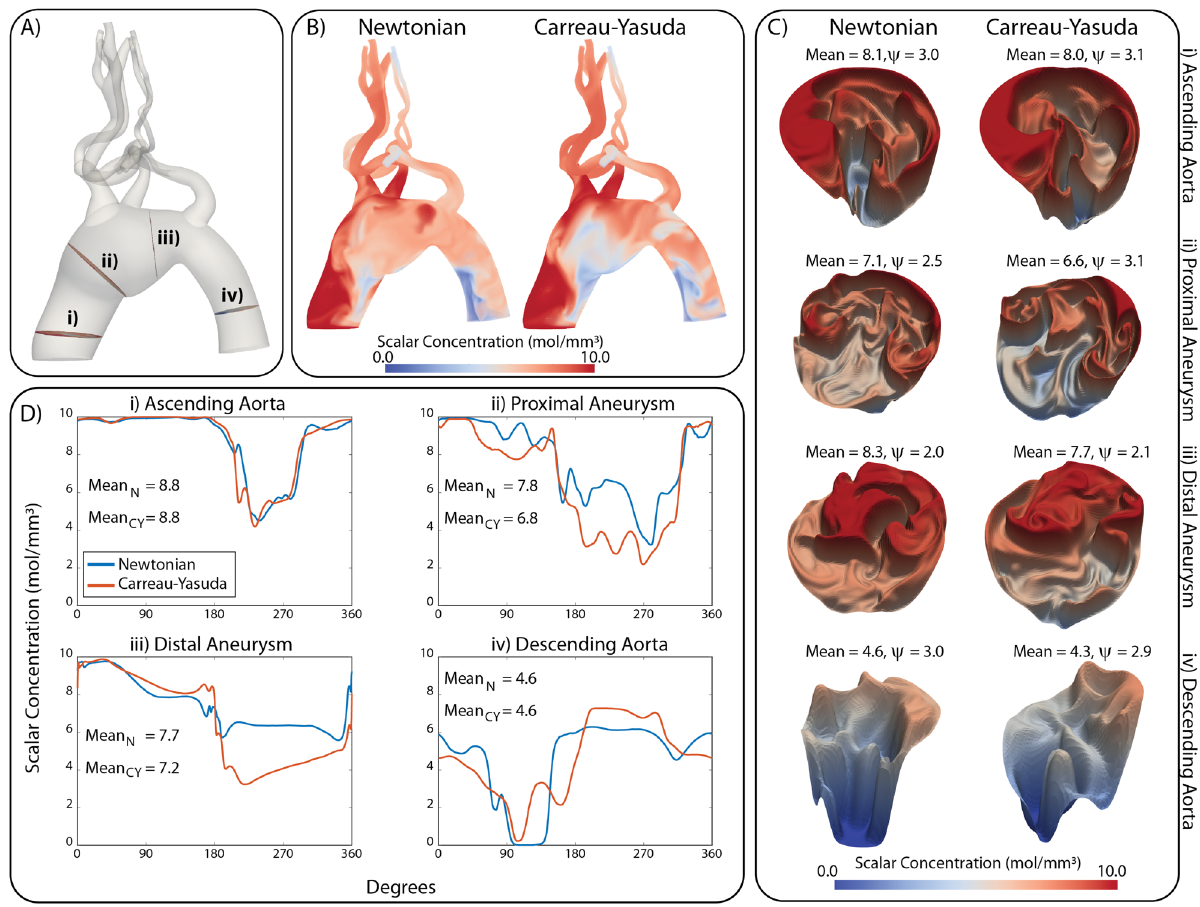
Figure 7. ( A ) Arterial computational domain highlighting four locations (i–iv) along the aortic arch. ( B ) Volume rendering of the scalar field for the Newtonian and non-Newtonian solutions after three cardiac cycles 2.92s ). ( C ) Warp visualization of the scalar field at locations (i–iv). ( D ) Scalar concentration along the (time t = aortic wall at locations (i–iv) for Newtonian and non-Newtonian